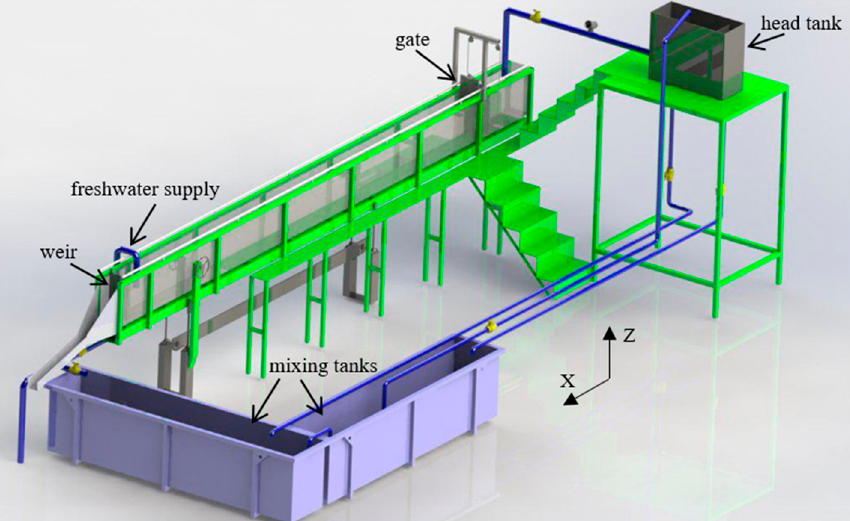
Figure 2. Schematic sketch of the experimental set-up. The flume was 10 m long, 0.3 m wide, and 0.7 m deep, capable of having different bottom slopes. A sliding vertical gate located at a 1.25 m distance from the upstream end of the flume divided this into two sections of unequal length. Additionally, an overflow weir was at the downstream end of the flume kept the depth of lighter ambient fluid constant during each experiment. The upstream of the gate was occupied by the dense fluid while the downstream part was occupied by freshwater simulating a reservoir where a density current can propagate. The density currents were initiated by the sudden removal of the vertical lock gate. Once the gate was opened, a density current (heavier fluid) advanced through the fresh ambient water (lighter fluid) by a raised front (also known as the head) in the form of an underflow. After the front reached the downstream end of the channel, it was directed for withdrawal. Thereafter, a shallower steady and quasi-uniform layer of density current was formed known as the body (see Figure 3) which is the focus of this